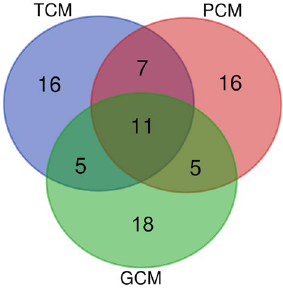
Figure 1. Venn diagram representing distribution of the studied 39 chicken breeds between the three classification (clustering) models: TCM traditional classification model, PCM phenotypic clustering model, GCM genotypic clustering model. Eleven breeds shared between the three models are core